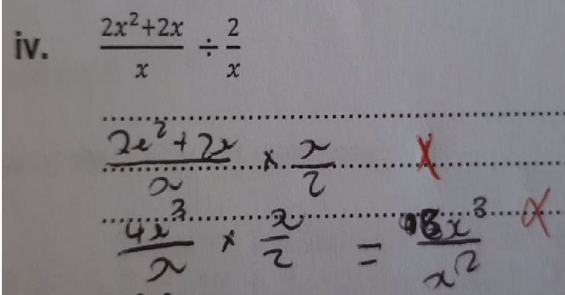
Figure 15: Learner D, School